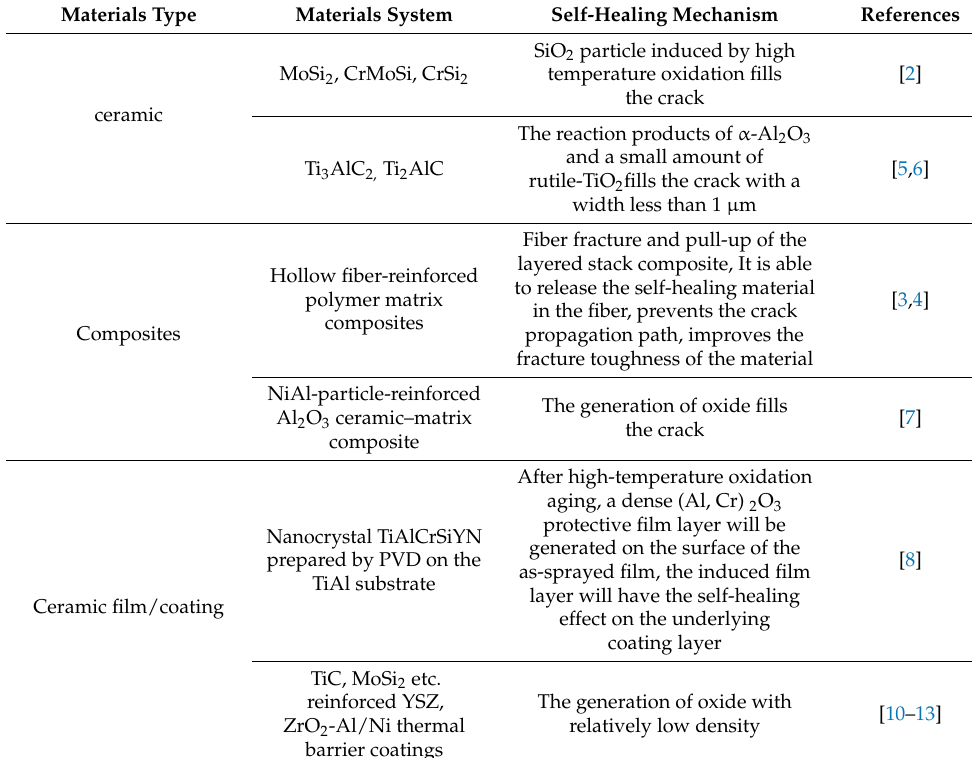
Table 2. Partial research progress of the self-healing